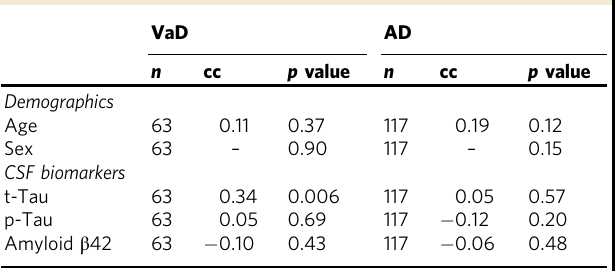
Table 3 Correlations between CSF LCN2 levels, demographics, and CSF